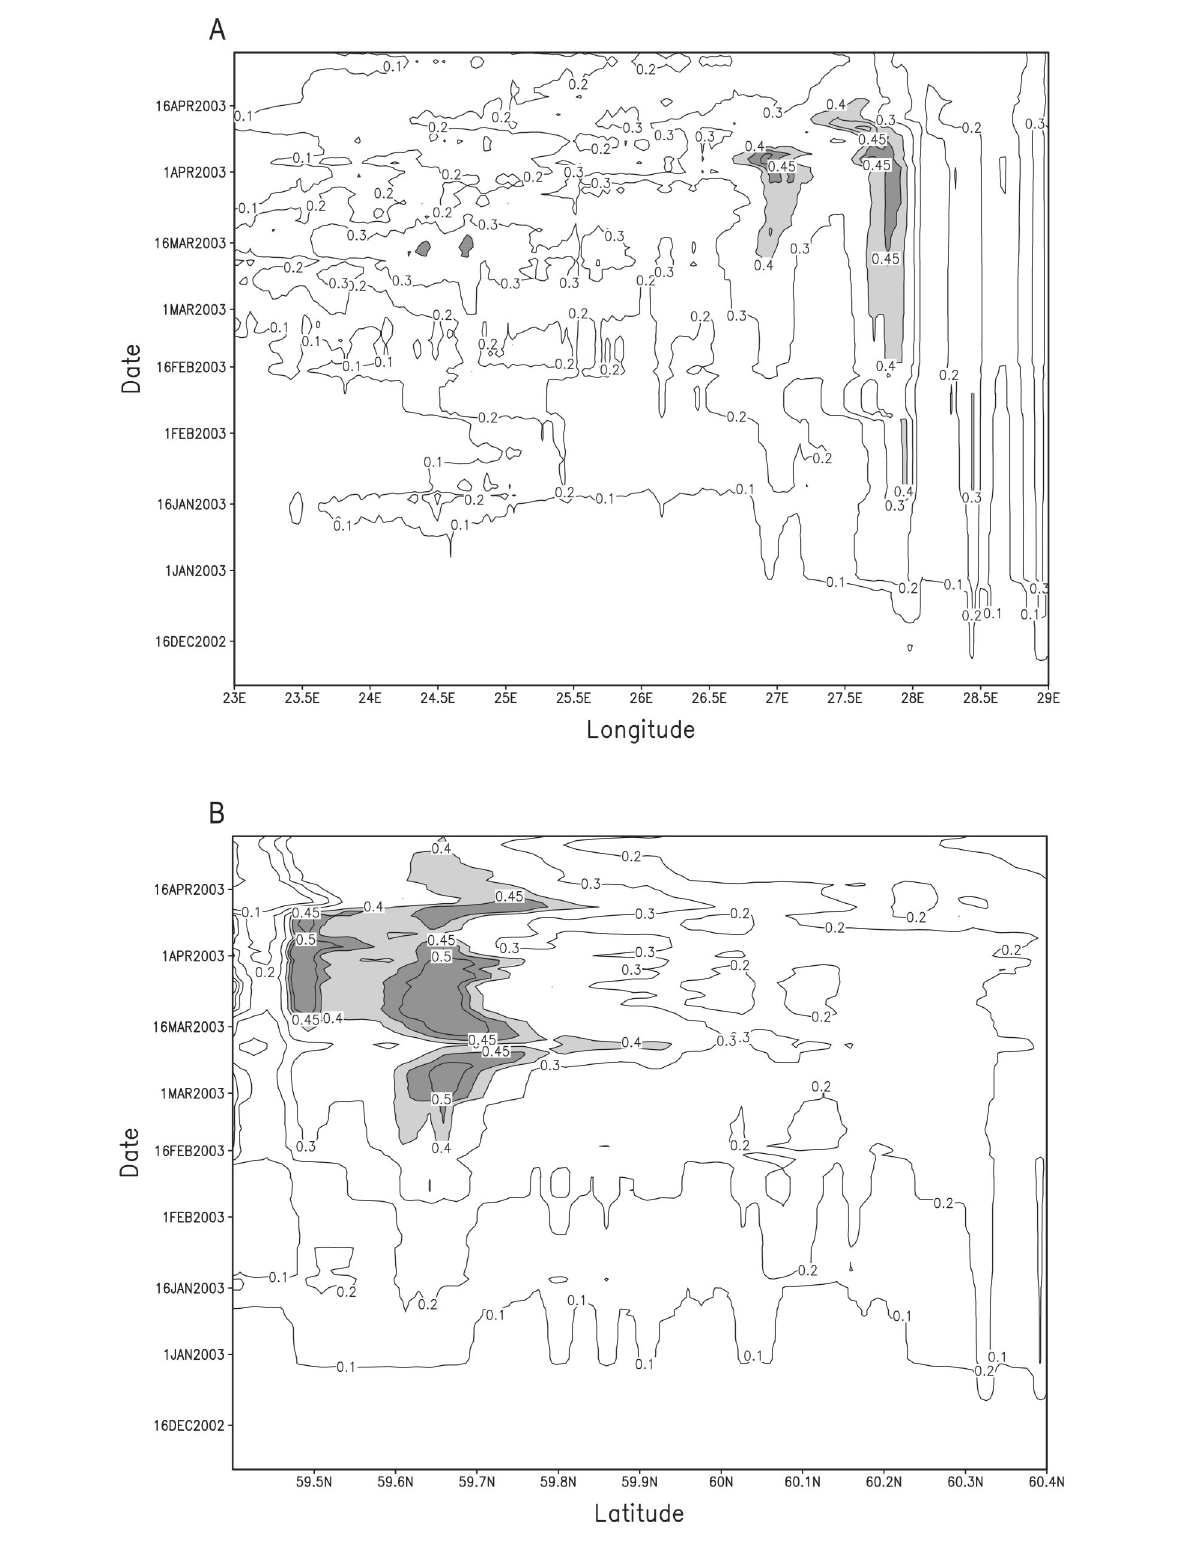
Fig. 9. Mean deformed ice thickness (m) over the latitudes ( A ) or longitudes ( B ). The extremes area (ice thickness > 0.4; 0.45) is